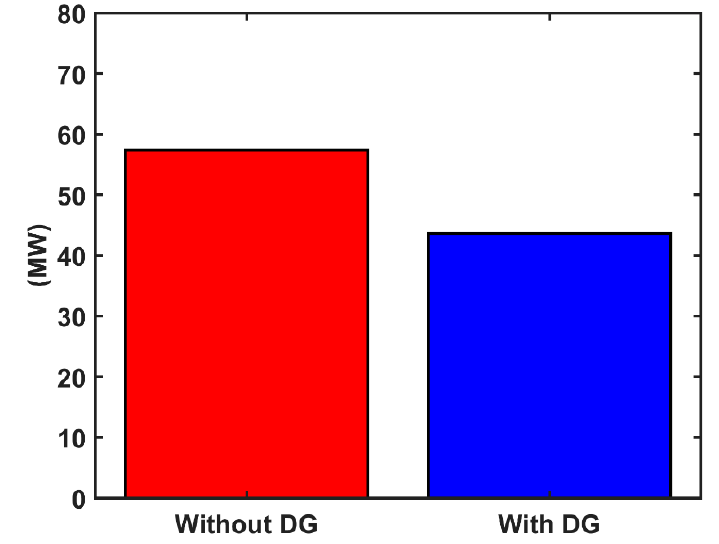
Figure 5. Power loss before and after installing the DG resources.